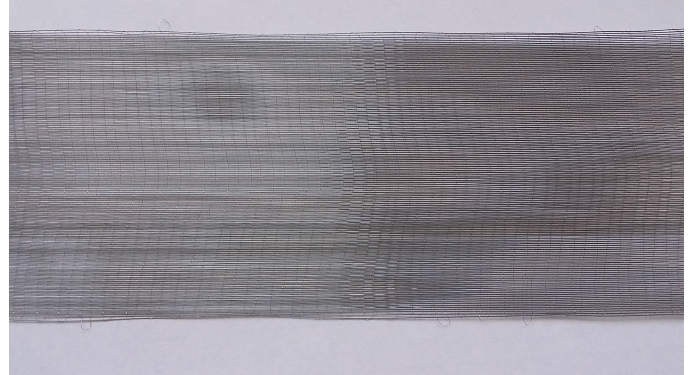
Figure 3. Tungsten weaves with 150 µ m wires utilised to form a 50 mm wide weave.